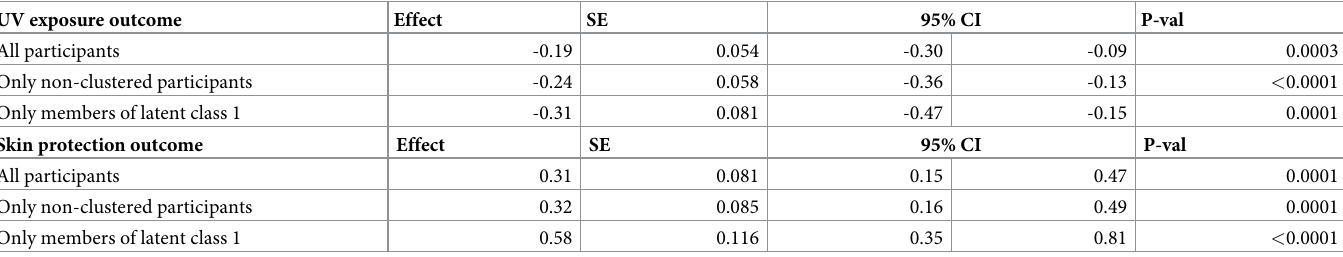
Table 3. Intervention effects on primary outcomes at 12 weeks, by cluster and latent class